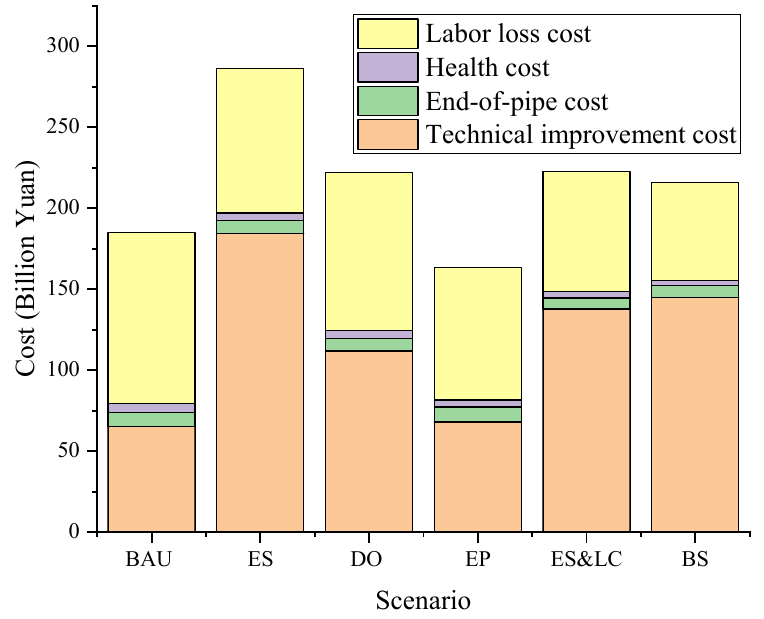
Figure 7. Cumulative costs from year 2015 to 2035.